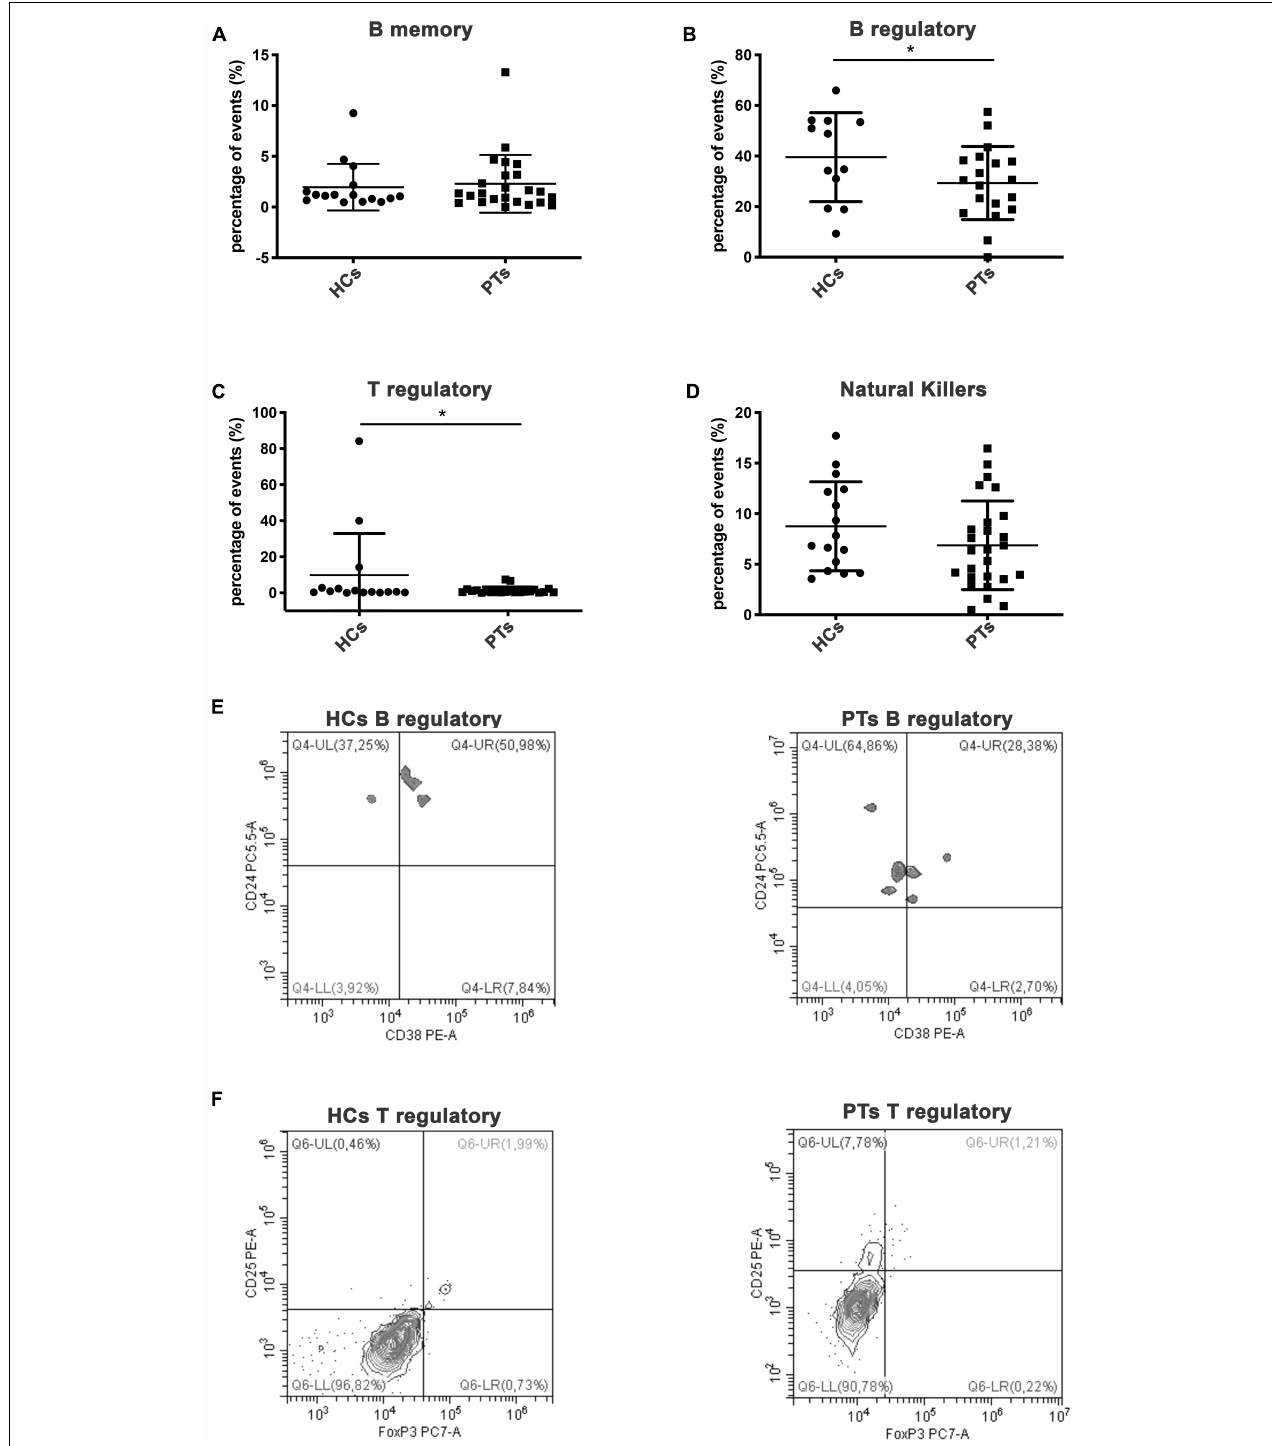
FIGURE 1 | Lymphocytes subpopulations. Scatter plot graphs representing the percentage of events of lymphocyte subpopulations (A) memory B cells (CD45 + /CD3 + /CD19 + /CD27 + ), (B) regulatory B cells (CD45 + /CD19 + /CD38 + /CD24 + ), (C) regulatory T cells (CD4 + /CD25 + /FoxP3 + ), (D) natural killer (CD45 + /CD3 + /CD16 + /CD56 + ); * p -value < 0.05 (Student’s t -test). Representative dot plot graphs of flow cytometry analysis of lymphocytes subpopulations. (E) B regulatory lymphocytes of HCs and PTs are shown in Q4-UR (underlined) representing CD38 + /CD24 events previously gated on CD45 + /CD19 + . (F) T regulatory lymphocytes of HCs and PTs are shown in Q6-UR (underlined) representing CD25 + /anti-FoxP3 events previously gated on CD4 + .